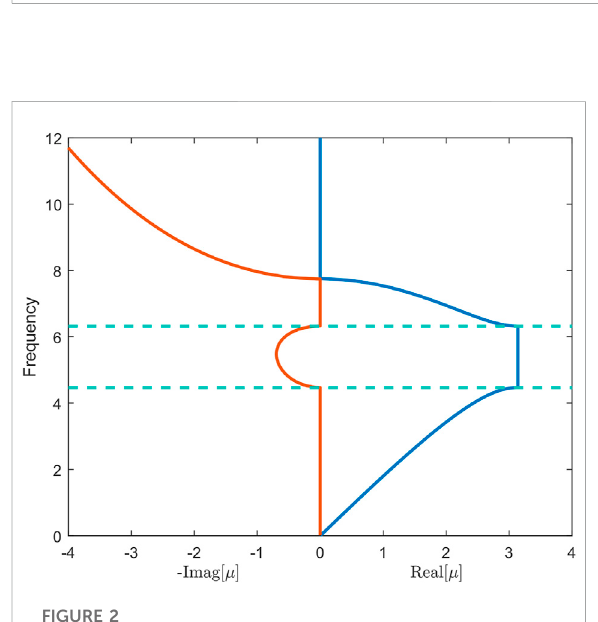
FIGURE 2 Dispersion curvesshowing the real part and imaginary part of propagation constant kd . The start frequency and cut-off frequency of the band gap are indicated by the dashed lines. The parametersoftheunitcellare m a =1, m b =2,and k a = k b =20.